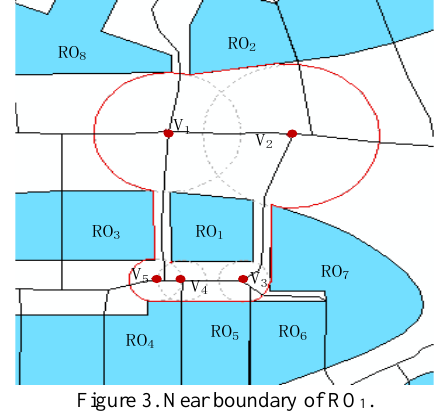
Figure 3. Near boundary of RO 1